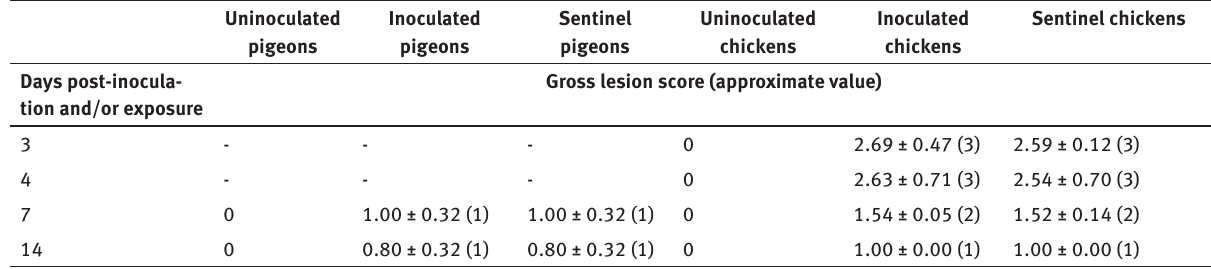
Uninoculated Inoculated Sentinel Uninoculated Inoculated Sentinel chickens pigeons pigeons pigeons chickens chickens Gross lesion score (approximate value)